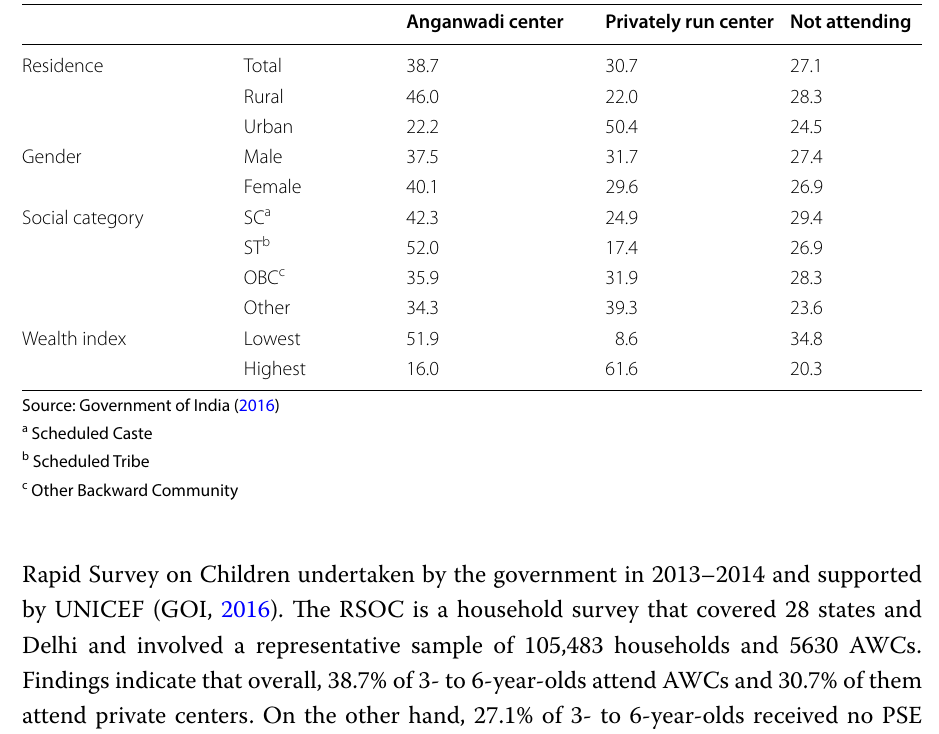
Table 2 Percentage of 3- to 6-year-olds receiving preschool education (2013–2014)